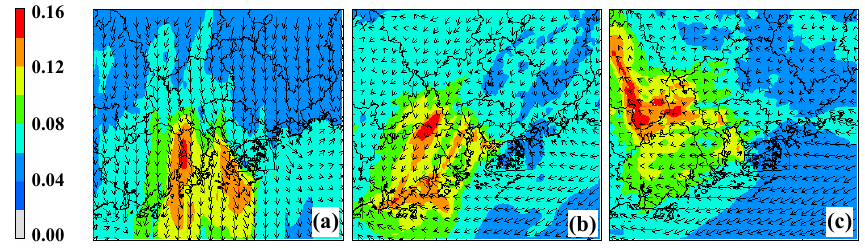
Fig. 7. Simulated surface O 3 concentrations superimposed with the wind fields at 15:00LST on (a) 19 October, (b) 16 October, and (c) 29 October, taken as examples of the three O 3 evolution patterns, respectively.